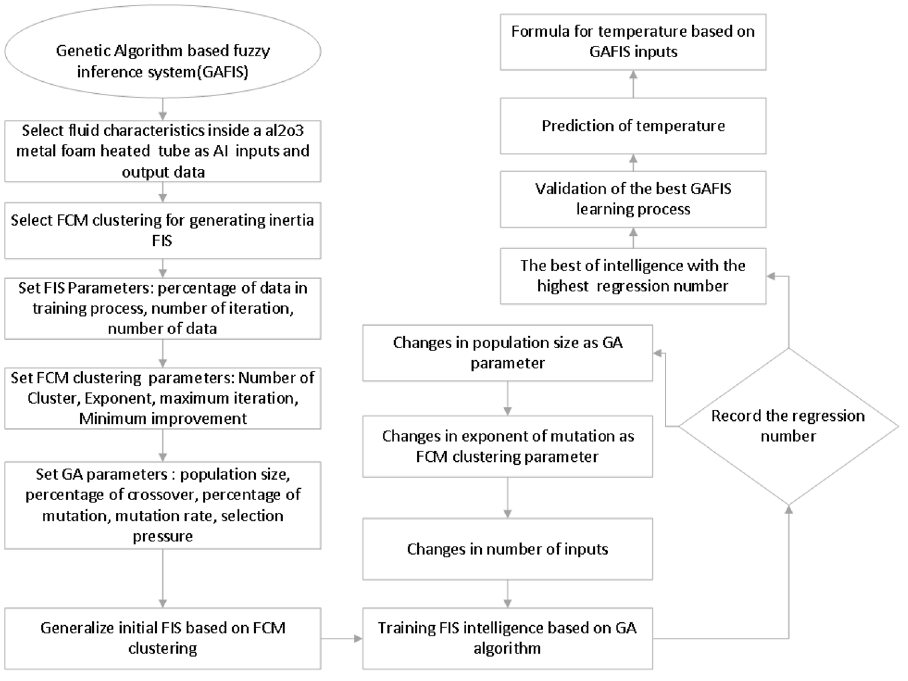
Figure 1. Flowchart of GAFIS